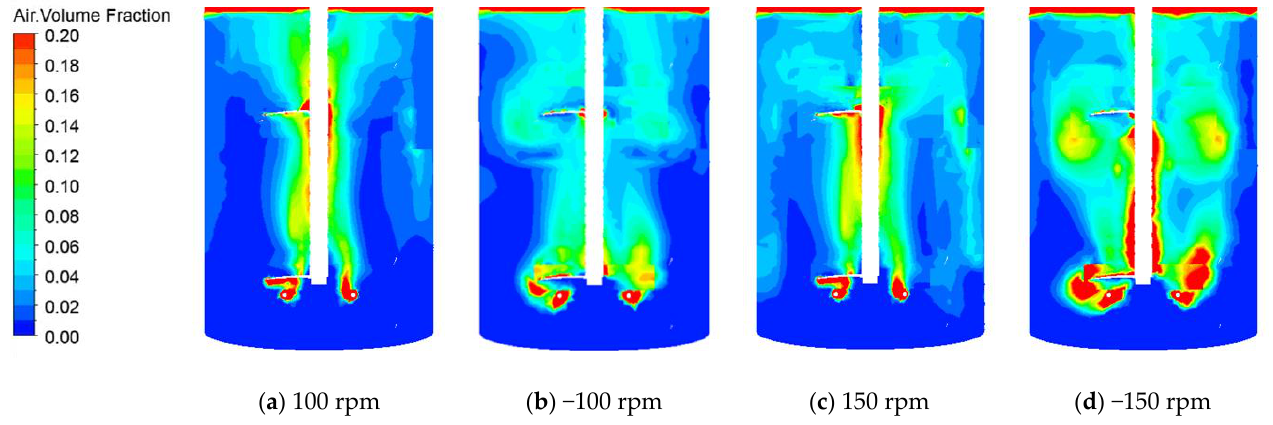
Figure 6. Gas distribution under different stirring speeds.